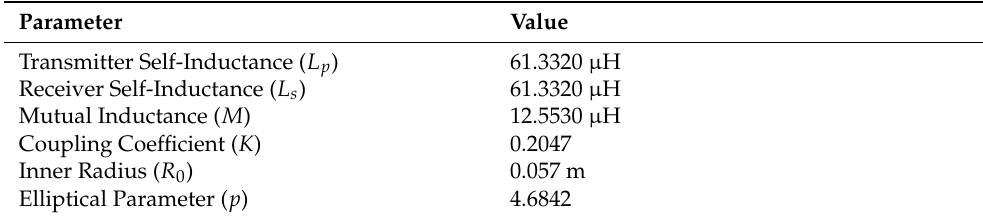
Figure 6. A 3D view of the final designed transmitter and receiver coils with a distance of D = 15 cm. The distance between the transmitter and receiver depends on the application, and it may vary with the distance we set in the simulation. Table 1. The parameters and their corresponding optimal values of the final designed coils.